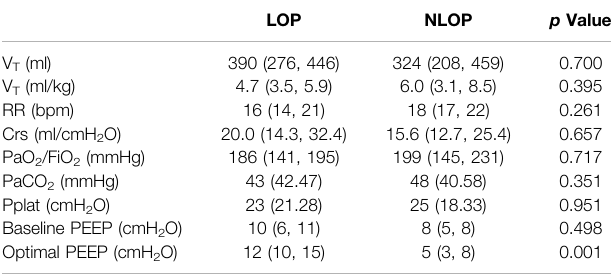
TABLE 3 | Difference of baseline ventilator parameters in LOP and